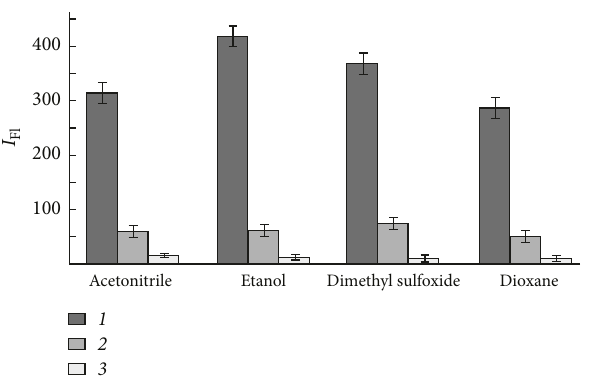
Figure 3: Dependence of the fluorescence intensity ( 𝐼 Fl ) of pyrene on CDA matrices on the logarithm of its concentration (2 ⋅ 10 −11 – 2 ⋅ 10 −6 g/L) in the sorbate. 𝐼 Fl is measured at 𝜆 em = 394 nm, 𝜆 ex = 320